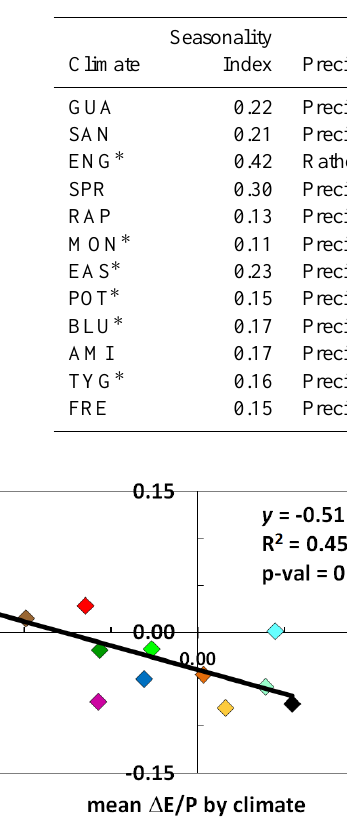
Figure 4 Fig. 4. Correlation between average 1E/P evaluated by catchment and by climate (sample size: 12; p value: 0.02 (this value expresses the probability that the observed trend is due to